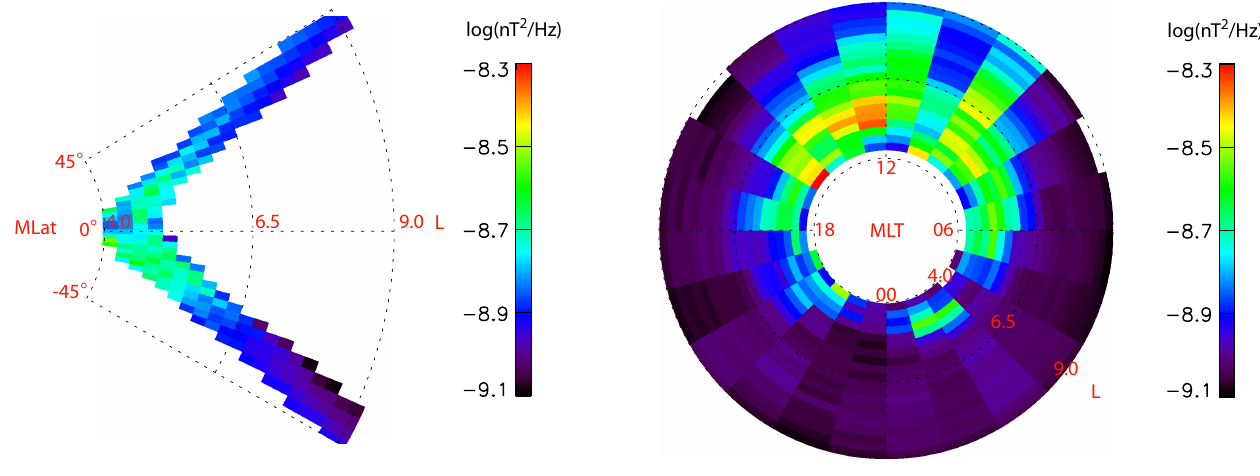
Fig. 3. Distribution of the spectral density in the frequency range 0 . 1 ≤ f/f ce < 0 . 5 dominated by lower-band chorus.